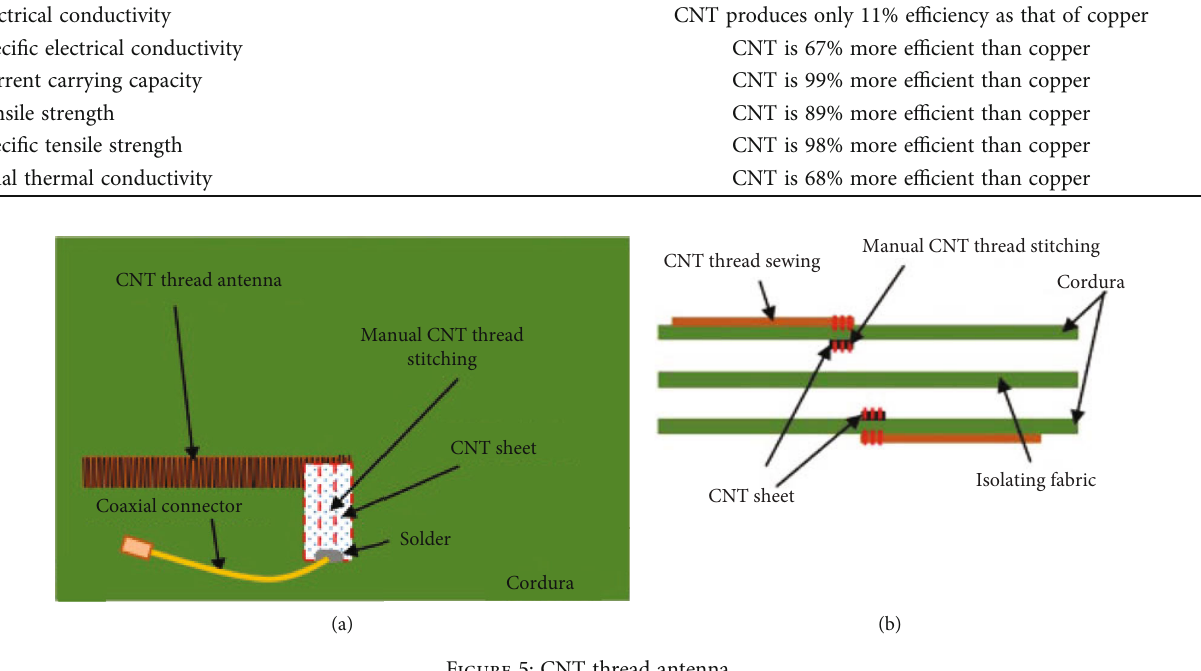
Figure 5: CNT thread